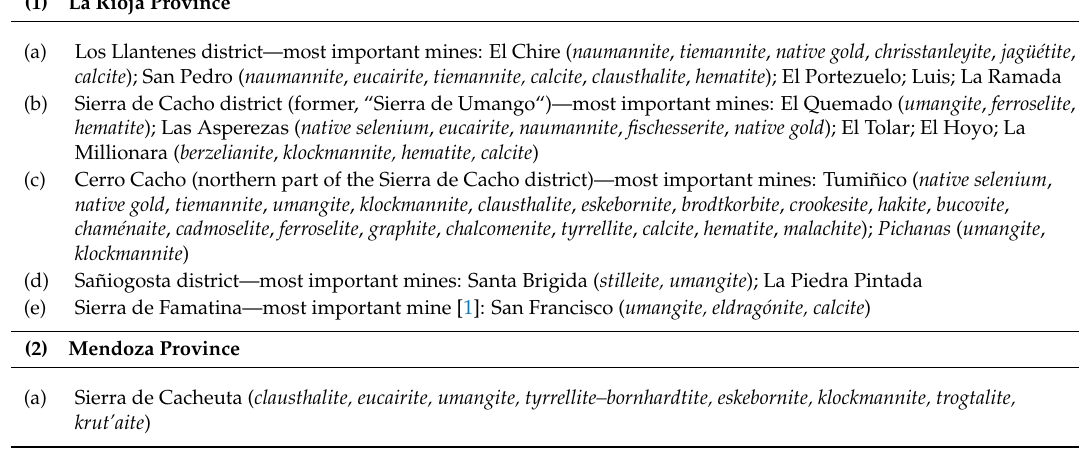
Table 4. Compilation of the most important Se occurrences of the provinces of La Rioja and Mendoza, Argentina [1]. Mineral species documented in color images by [1] are given in